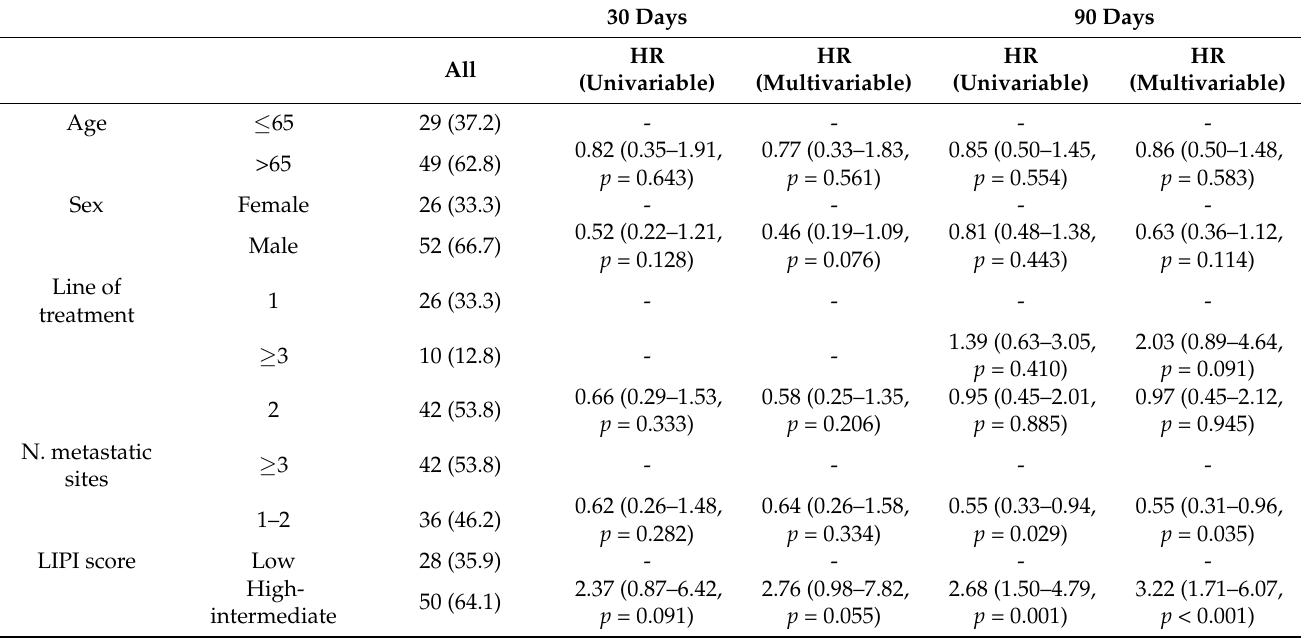
Table 4. Univariate and multivariate analysis for 30-day and 90-day survival including LIPI score. Abbreviations: HR, hazard ratio; n.,